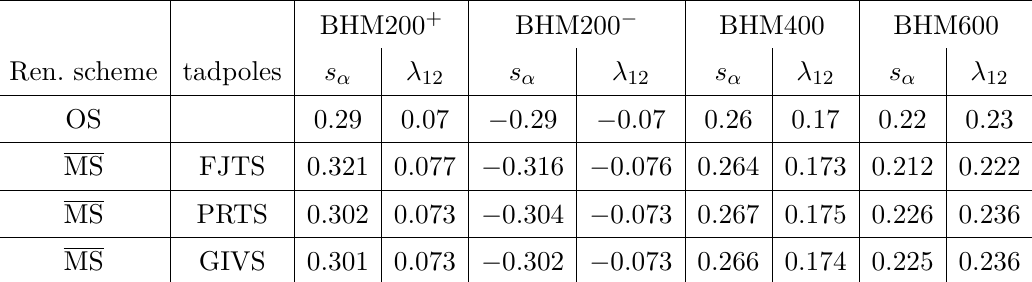
Table 4 . Conversion of parameters from the OS scheme as input scheme to the different MS renormalization schemes at the central scale µ 0 = M h performed in the PRTS, using the bare parameters for tan α and λ 12 in the